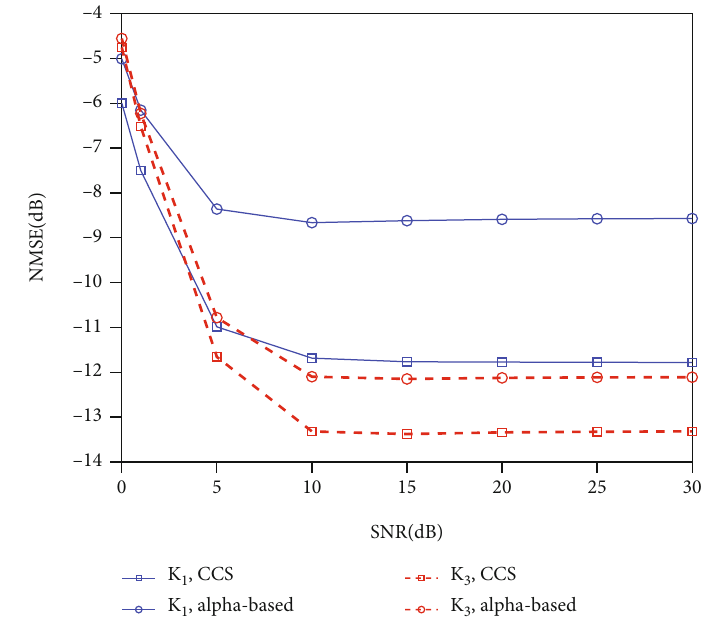
Figure 5: Normalized mean square spectrum estimation error NMSE vs. SNR for two methods using the Fourier basis: the alpha-based and the Blackman-Tukey estimation through LS-CCS, and for two di ff erent compression ratios: 8/21 ( K